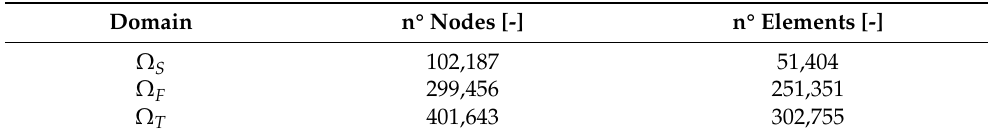
Figure 5. Computational domains for Micromirror 1: upper view of Ω S ( a ) and internal cut section of Ω − e F generated with an e 2 3 plane passing through the centre of the box ( b ). Table 2. Number of elements and number of nodes associated with solid, fluid, and full domain triangulation for Micromirror